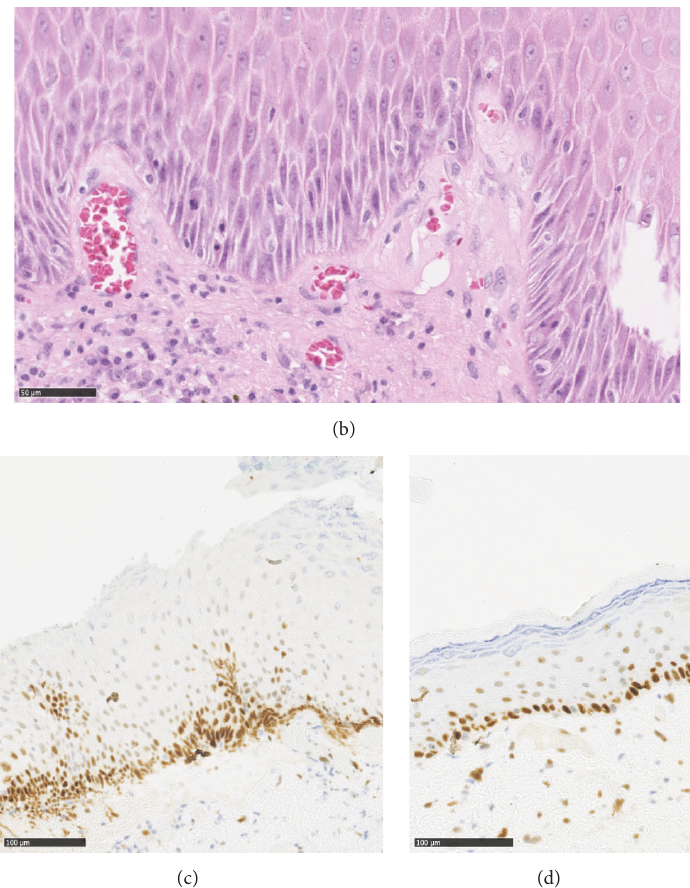
Figure 4: Microscopic and immunohistochemical aspects of 2nd excision. At low power view, the epithelium appeared thickened with parakeratosis and elongated rete ridges (a). At high power view, note the disorderly basal cell layer, prominent intercellular bridges, prominent nucleoli,andmitosis(b).Immunoreactivityofp53appearedlimitedtothebasalandsuprabasallayersoftheepithelium,withweaktomoderate intensity (c). Immunoreactivity of p53 in adjacent “normal” epithelium